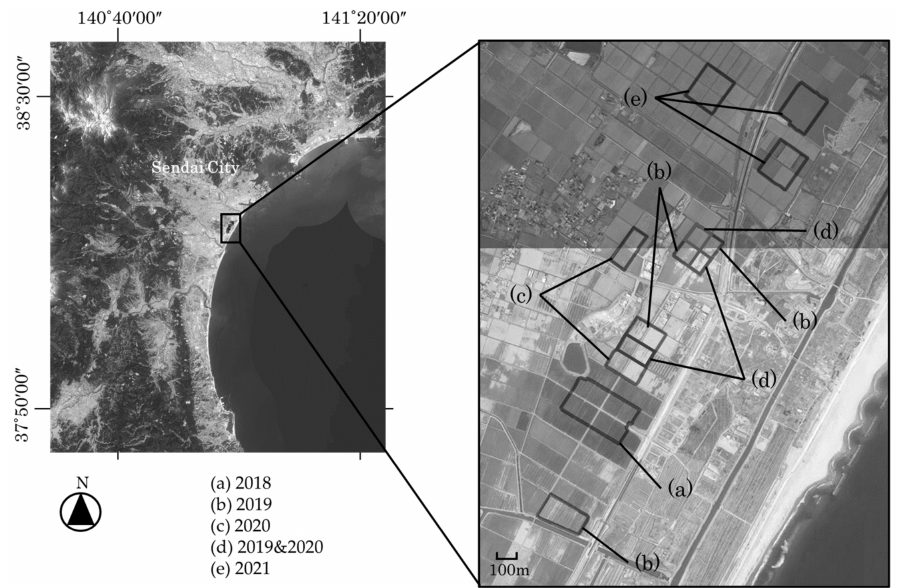
Figure 1. Location of research fields in this study. This figure was modified from aerial image taken by the Geospatial Information Authority of Japan (https://www.gsi.go.jp/top.html accessed on 18 November 2022). The black rectangles in the right figure are the fields investigated in 2018, 2019, 2020 and 2021. Table 1. Number of investigation points and cultivation details from 2018 to 2021.